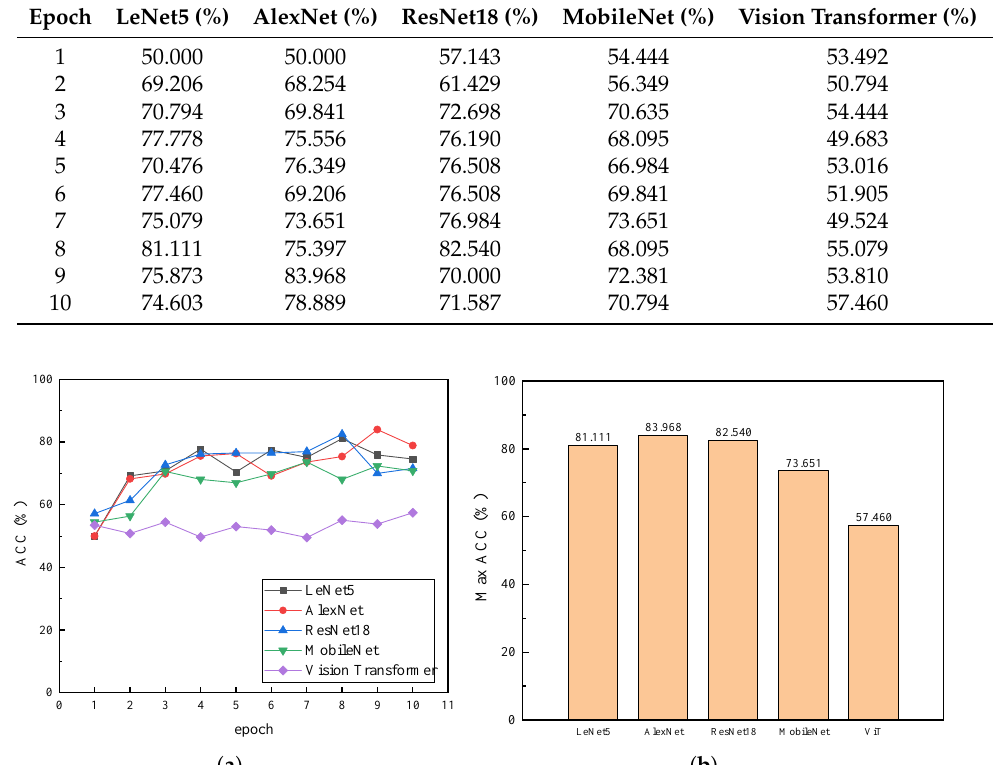
Table 6. Accuracy of pneumonia recognition by each model before data augmentation and after GPU loading.